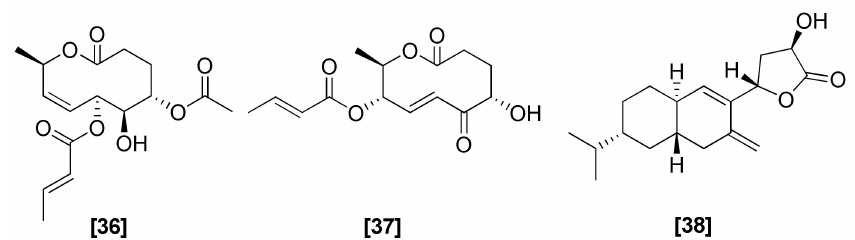
Figure 10. Structures of antifungal lactones from Trichoderma spp.: [36] cremenolide, [37] aspinolide C, [38] cerinolactone.